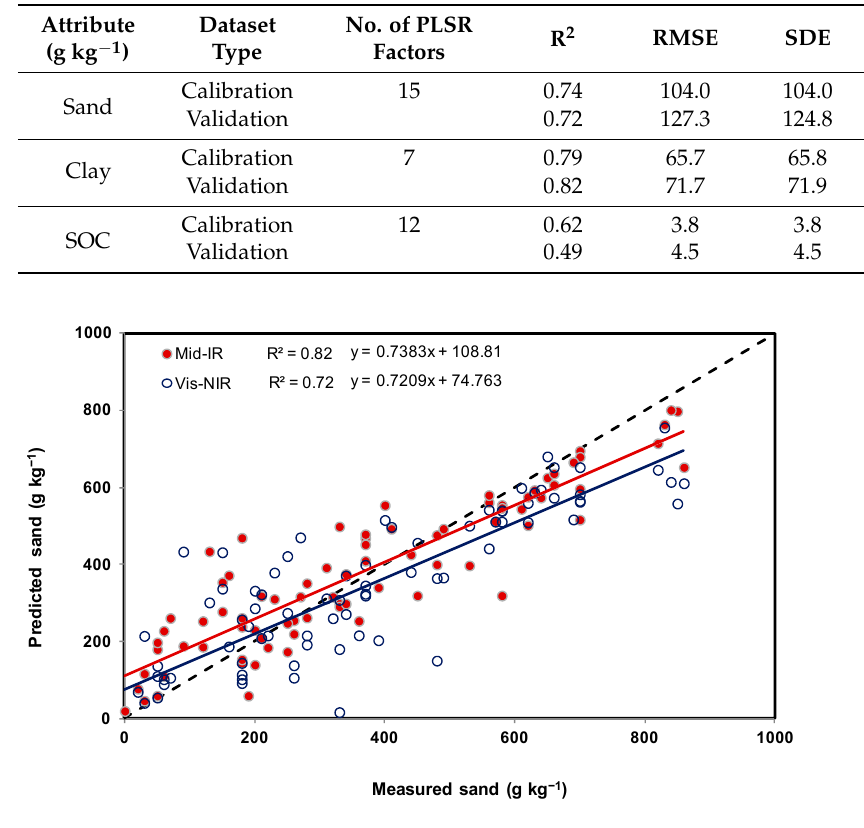
Figure 9. Relationships between measured and predicted sand, with dots representing validation examples in accordance with Tables 3 and 4.